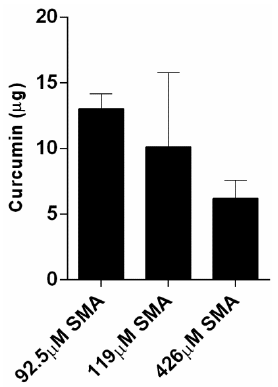
Figure 2. The remaining amount of the 1 mg curcumin following its encapsulation in SMA at indicated concentrations. The data represent the mean ± SEM of triplicates. Table 2. The curcumin encapsulation efficiency of three different concentrations of SMA.